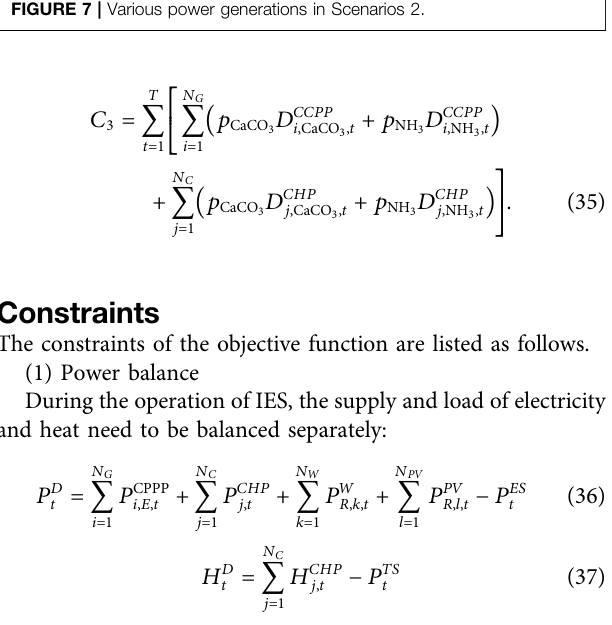
FIGURE 6 | Various power generations in Scenarios 1. FIGURE 7 | Various power generations in Scenarios